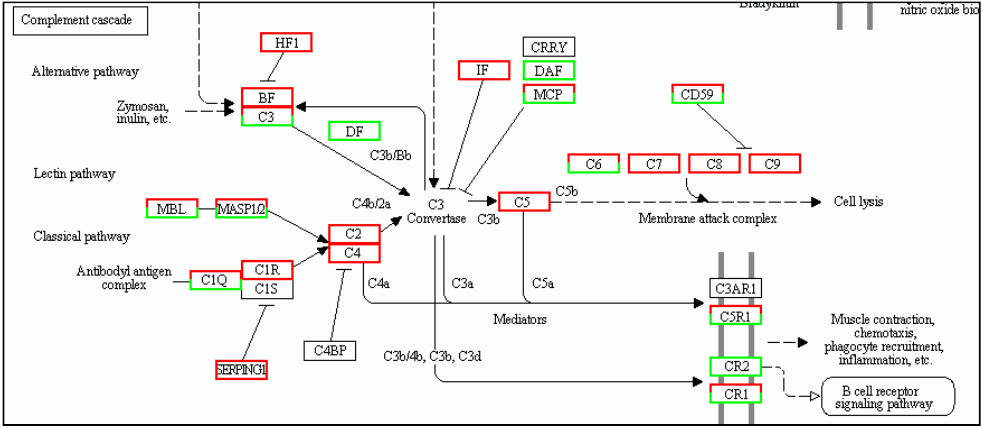
Figure 5. Complement cascade pathway mapping in spleen by KEGG. Red boxes indicate significantly differentially up-regulated expression, green box indicate down-regulated expression and white boxes indicate unchanged expression in the transcriptomic profile.